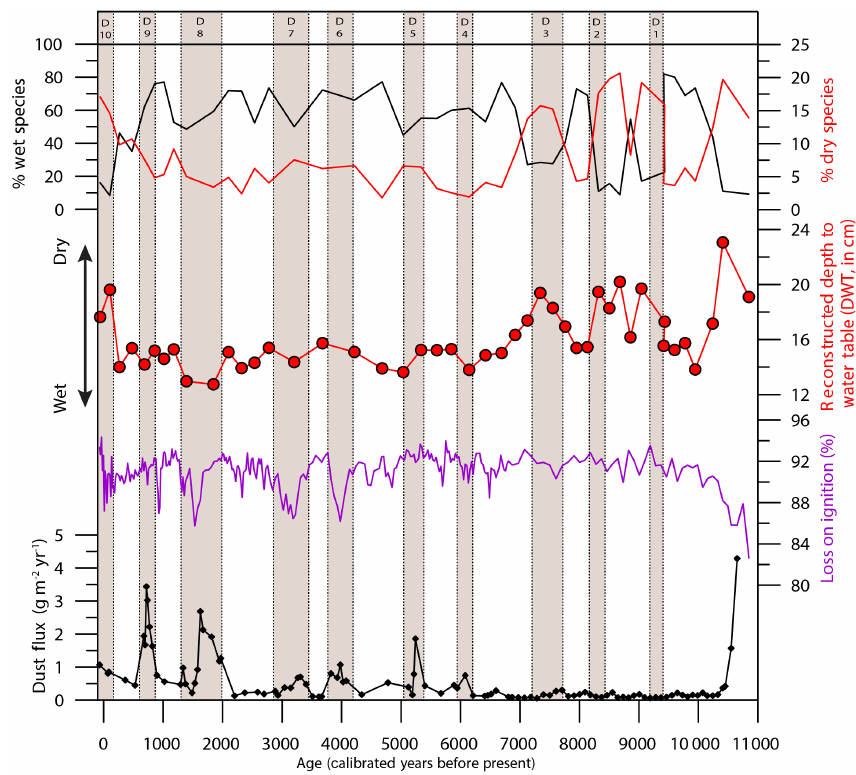
table (DWT), and organic matter (as indicated by loss on ignition). Vertical bars as in Fig.